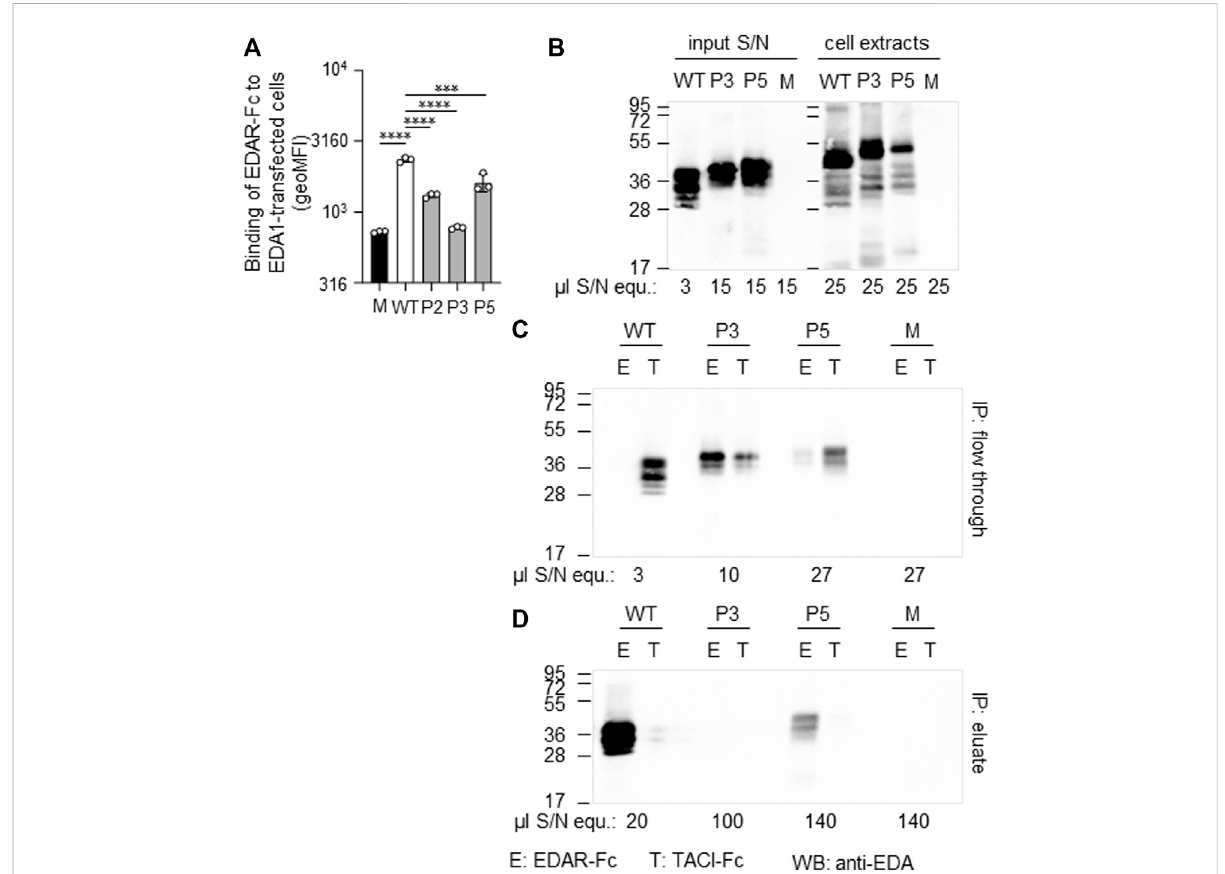
FIGURE 5 Expression and receptor-binding ability of EDA variants p. Gly175Val (P2), p.Pro389LeufsX27 (P3) and p.Ter392GlnfsX30 (P5). (A) HEK 293T cells expressing full-length EDA or variants thereof were monitored by FACS for their capability of binding to EDAR-Fc, indicated as geometric mean of fl uorescence intensity (geoMFI). Mock transfectants (empty plasmid) were used as negative control (M, mock). (B) Cell extracts (right hand side) and conditioned supernatants (left hand side) of transfected HEK 293T cells were analyzed by WB with anti-EDA mAb Renzo-2. Amounts of sample loadedareshownasµlequivalentofconditionedmedium(µlS/Nequ). (C,D) ConditionedsupernatantsofHEK293T-cellswereimmunoprecipitated with immobilized EDAR-Fc (E) or TACI-Fc (T) as control. The unbound ( fl ow through) and retained (eluate) fractions were analyzed by WB with anti- EDA mAb Renzo-2. The respective volumes of samples loaded are shown as µl equivalent of conditioned medium. The migration positions of molecular weight markers (in kDa) are indicated on the